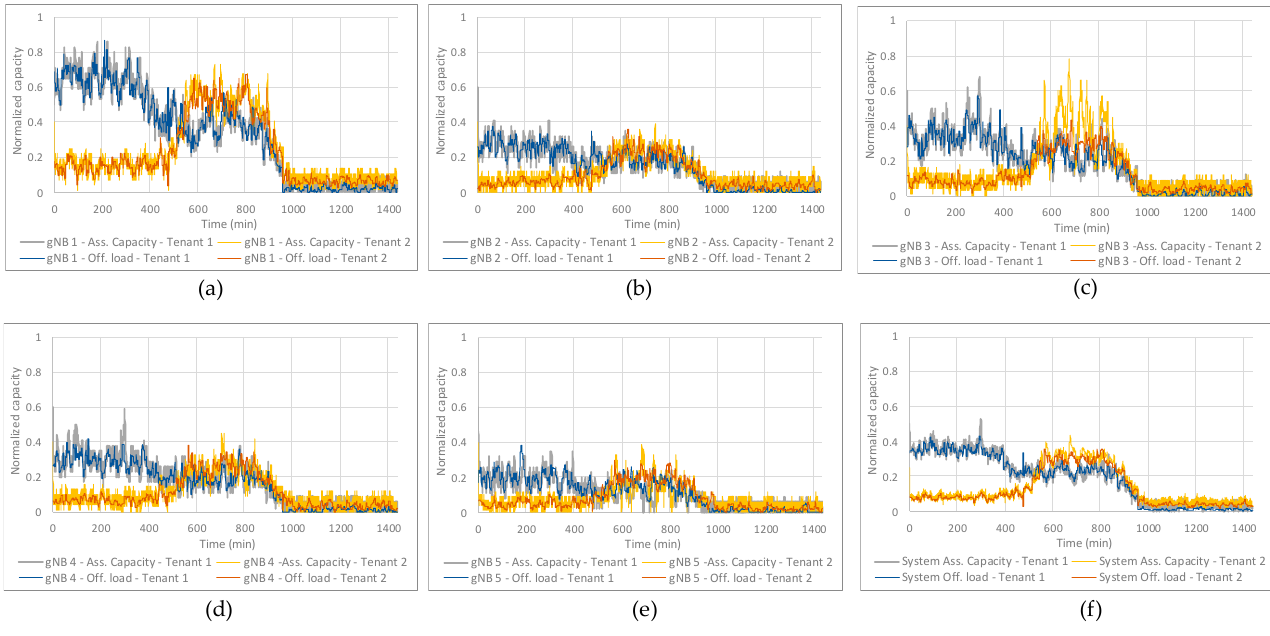
Figure 5. Evolution of the aggregated reward by tenant 1 and tenant 2 during training.